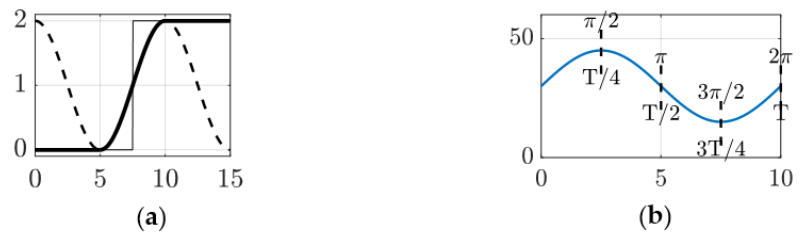
Figure 2. ( a ) Piecewise sinusoidal trajectory with a slew time/maneuver time of 5 s and a quiescent time of 5 s before and after the slew ( b ) A nominal sine wave used to reveal relationship between points on the curve’s time and phase angle.